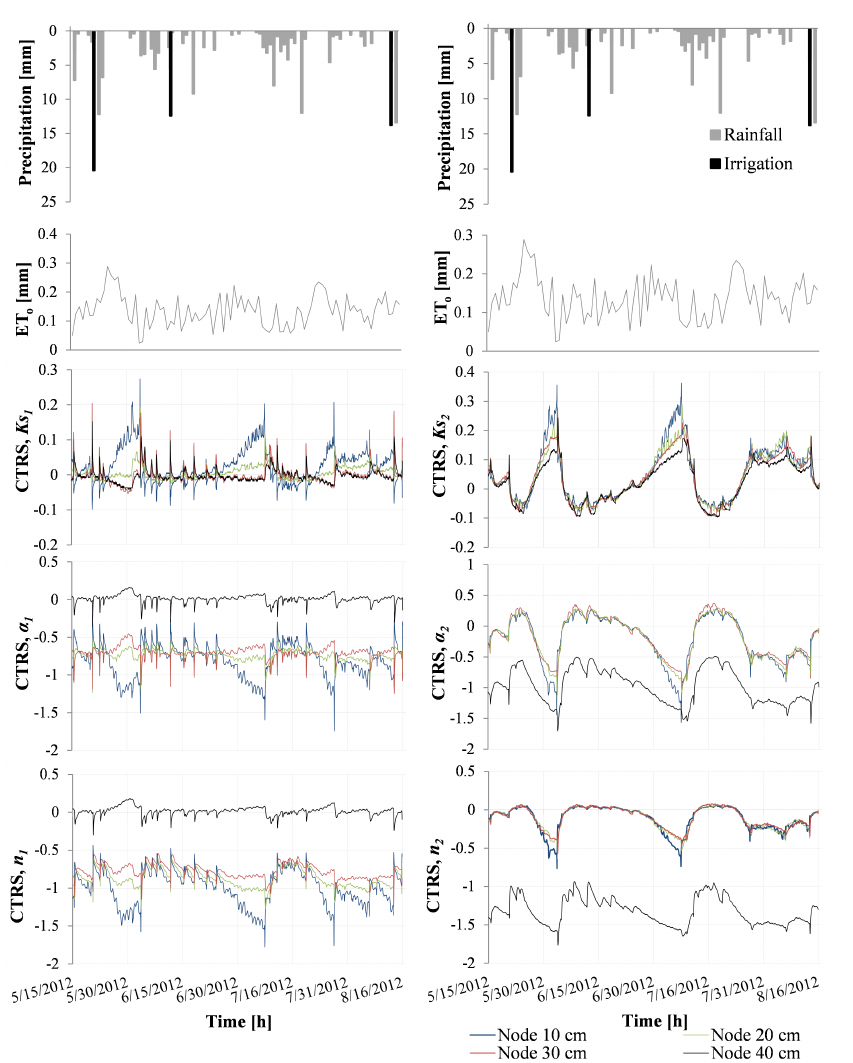
Figure 4. Parameter sensitivity as a function of time. The numbers 1 and 2 correspond to the first and second layer,